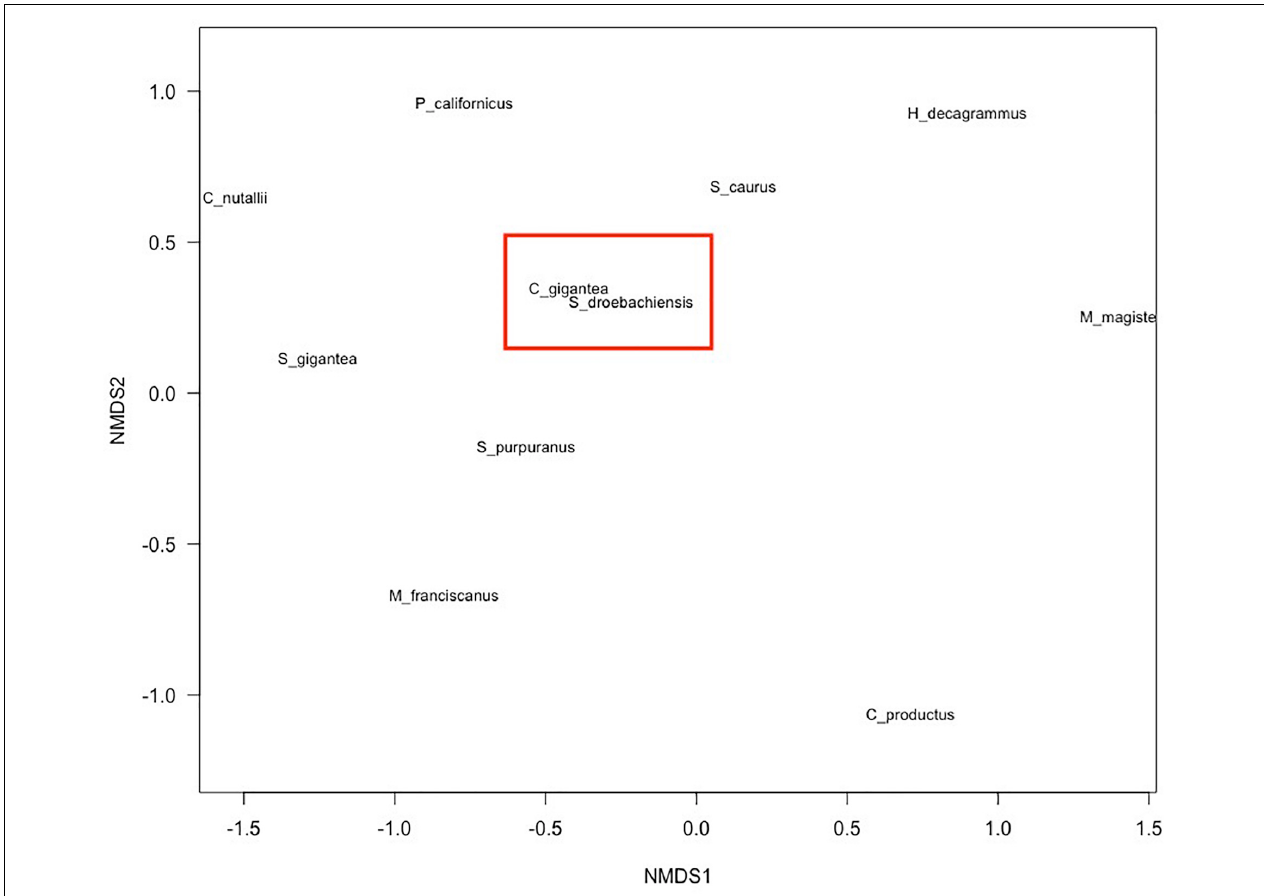
FIGURE 4 | Non-metric multi-dimensional scaling ordination showing the relationship of species co-occurrence. Two Songhees culturally important species, namely, S. droebachiensis and C. gigantea appear to be co-dependent (highlighted by the red box) Stress =